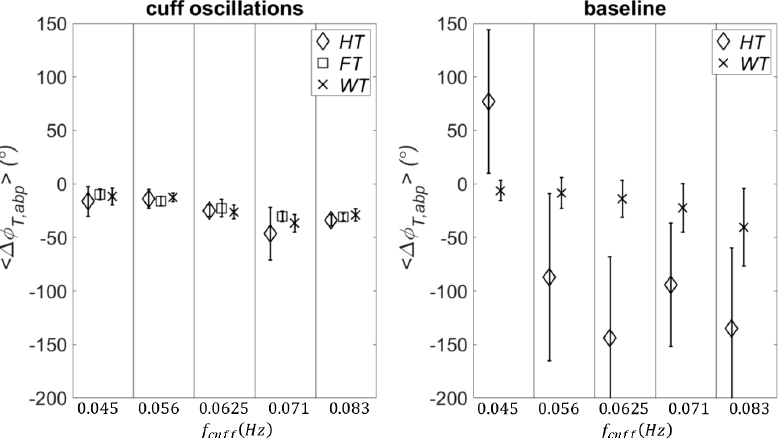
Fig. 2. Phase di®erence between T and abp at the cu® frequencies. On the left panel the phase di®erences were calculated as averages across the main lobe of the cu® frequencies with the analytic signal (HT), wavelet cross spectrum (WT), and cross power spectral density (FT) methods. For the wavelet (WT) and analytic signal (HT) methods, the averages were also carried out in the time intervals when the cu® was oscillating at each speci¯c frequency. On the right panel the time-frequency averages of the phase di®erences were calculated with analytic signal and wavelet methods during baseline. The vertical lines de¯ne the di®erent cu® frequencies. The error bars are the standard deviations across the frequencies of the main lobe of the cu® frequencies (FT) or across the temporal ranges of cu® oscillations (WT and